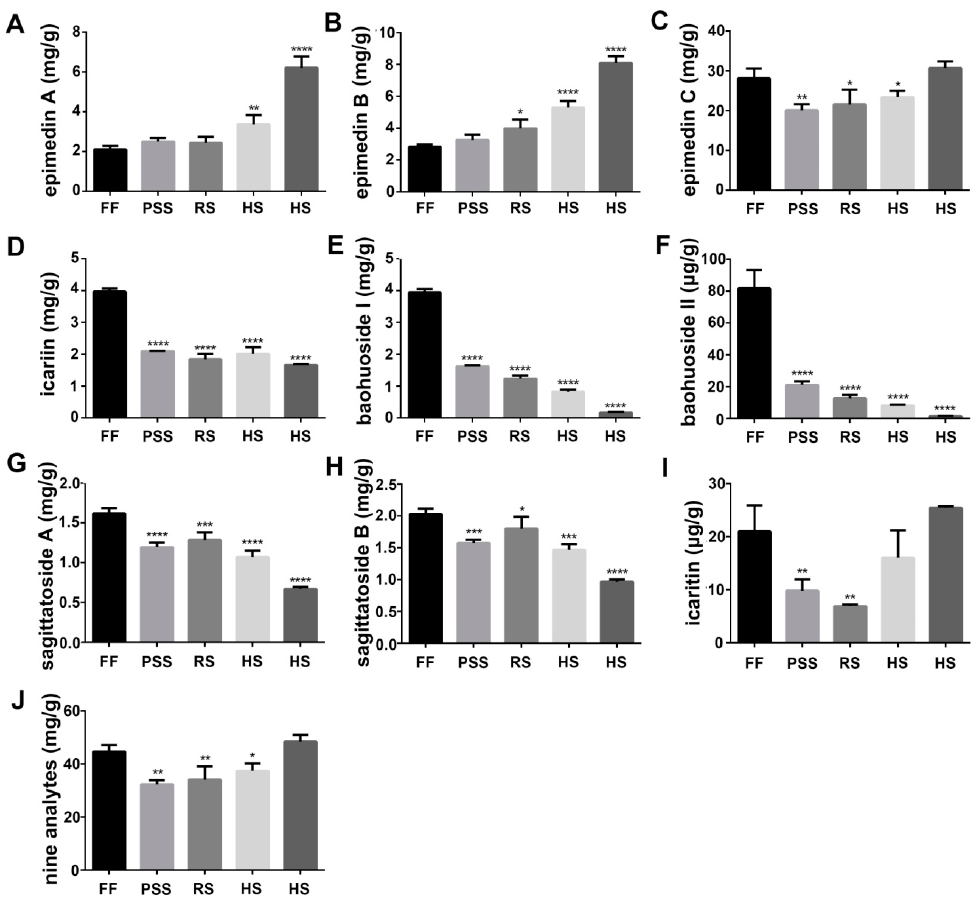
Figure 2. Quantitation results of nine icariin analogues in E. pubescens leaves at five growth stages: Full flowering stage (FF), peak seed set stage (PSS), ripening stage (RS), and two timepoints of harvest stage (HS). The observation dates were the same as described in Figure 1. * p < 0.05 and ** p < 0.01, *** p < 0.001 and **** p < 0.0001 meant significant difference of the measurement at the indicated stage compared with E. pubescens leaf at FF stage. The contents were calculated per gram dry weight. ( A ) epimedin A; ( B ) epimedin B; ( C ) epimedin C; ( D )icariin; ( E ) baohuoside I; ( F ) baohuoside I; ( G ) sagittatosides A; ( H ) sagittatosides B; ( I ) icaritin; ( J ) total content of nine analytes.